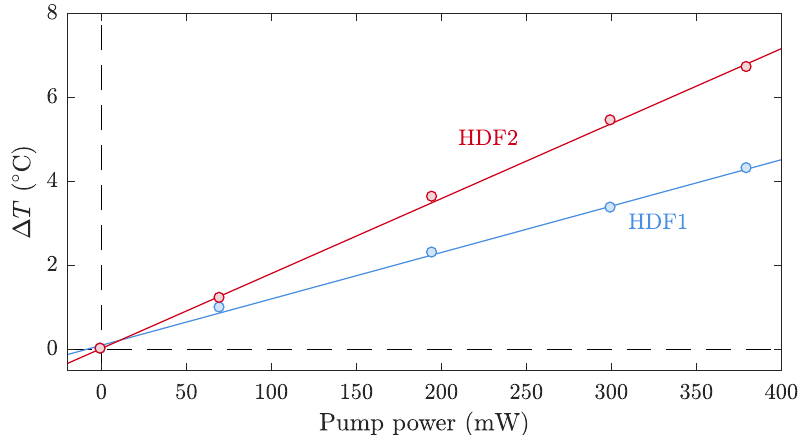
Figure 4. Measurement of the temperature increment of Holmium Doped Fiber 1 (HDF1) and HDF2 as a function of the pump signal power. Pump wavelength centered at